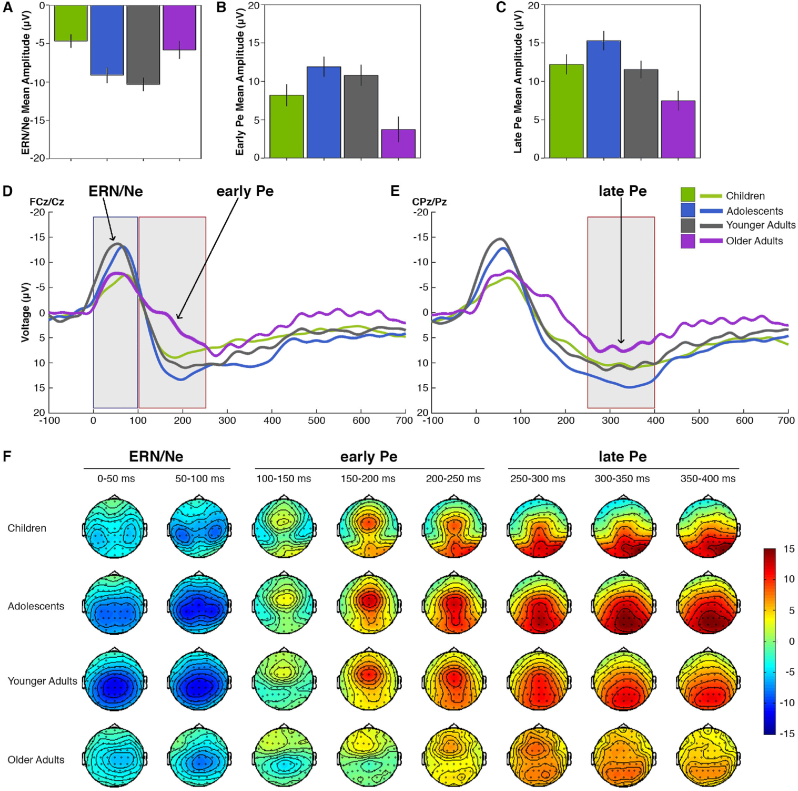
A–E: Grand averages of the response-locked ERP difference waveforms (error – correct) for the four age groups (A–C) and across time (−100 ms before to 700 ms after response, D-E), averaged for electrodes FCz and Cz for the early ERP components (ERN/Ne and early Pe, A-B and D) and for electrodes CPz and Pz for the late Pe component (C, E). Error bars in figures A–C indicate one standard error of the mean (SE). F: Scalp topographies of the response-locked ERP difference waveforms (mean amplitudes) 0–100 ms (ERN/Ne), 100–250 ms (early Pe) and 250–400 ms (late Pe) after response in 50 ms intervals.